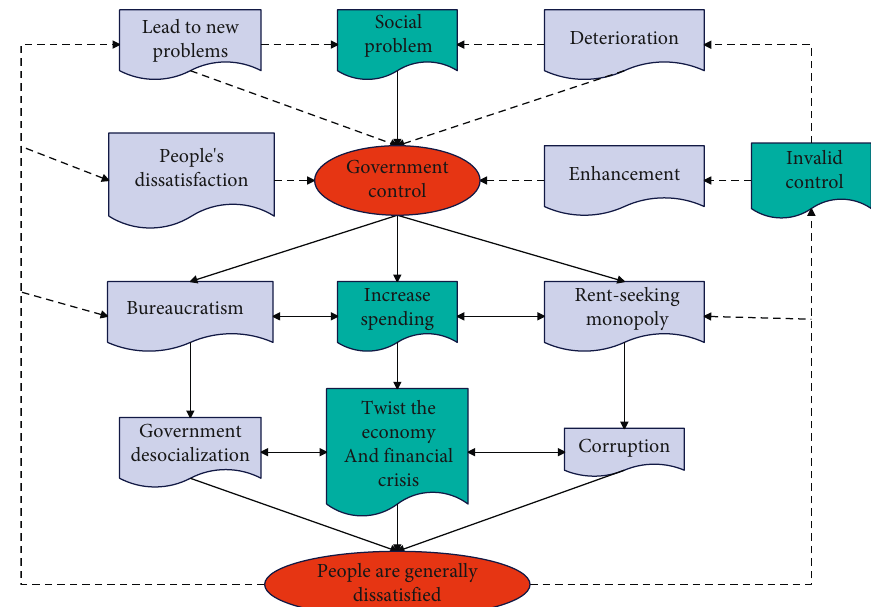
Figure 5: Traditional ways of solving social problems.